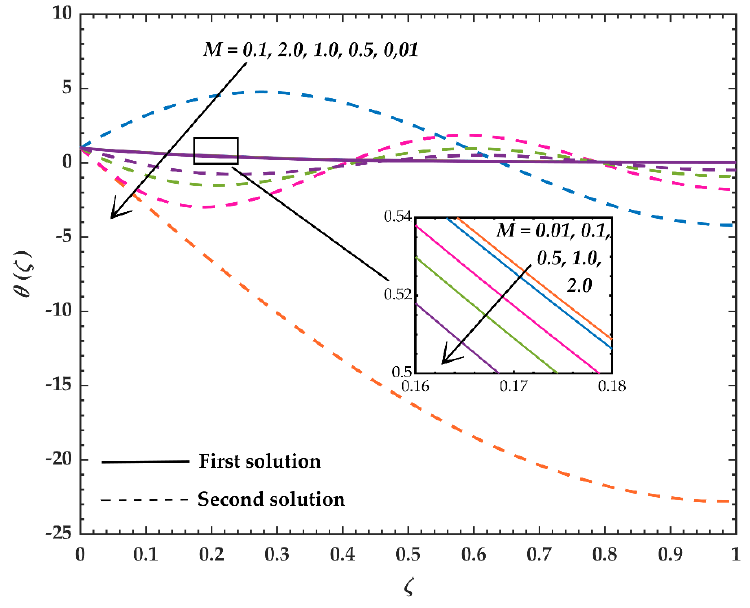
Figure 5. Temperature profiles, θ ( ζ ) when Pr = 30, We = 0.2, n = 0.6, S = − 0.3 and σ = 1.2 as M varies.